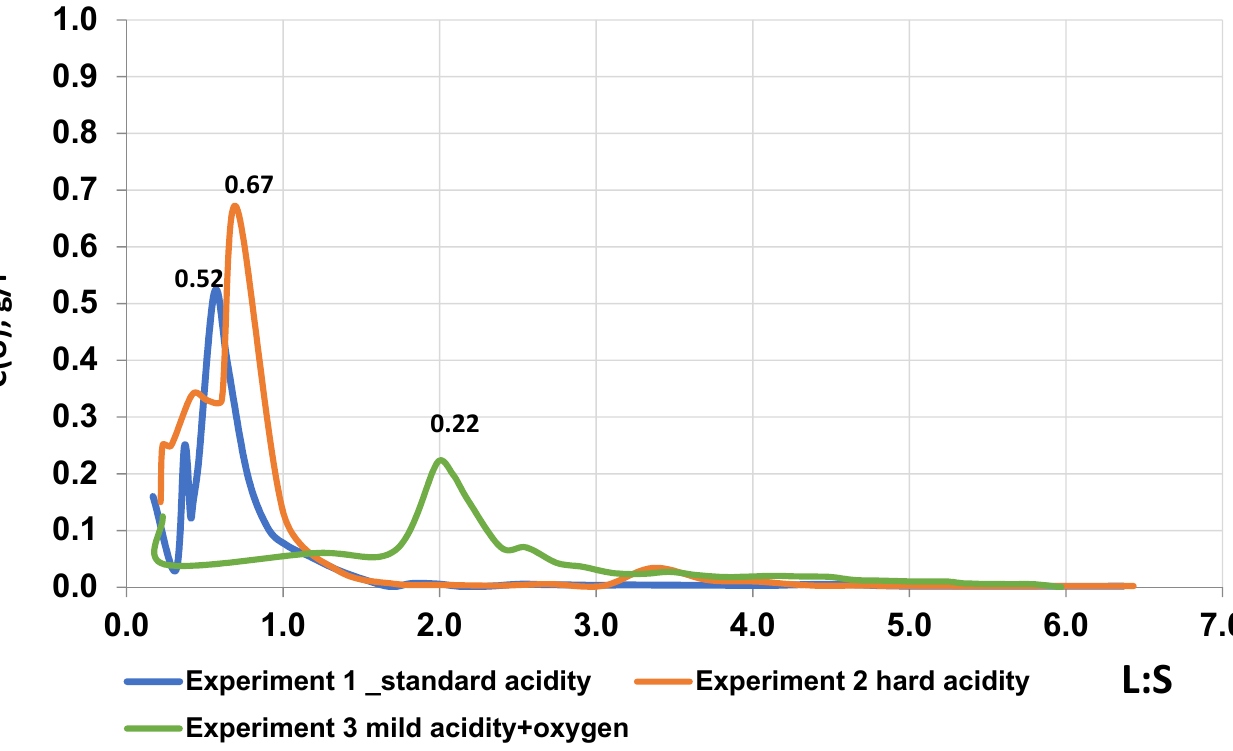
Figure 3. Uranium concentration values in productive solutions as a function of L:S.